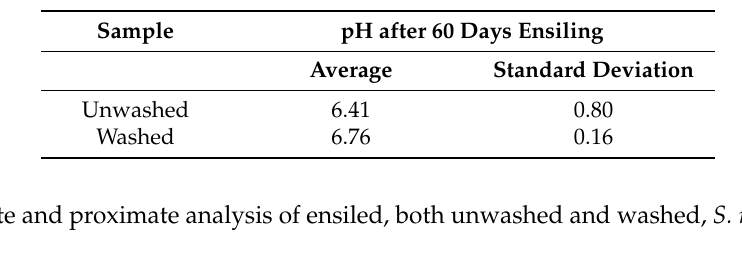
Table 6. Ultimate and proximate analysis for unensiled and ensiled S. muticum and the leachate produced from ensiling with and without washing pretreatment.